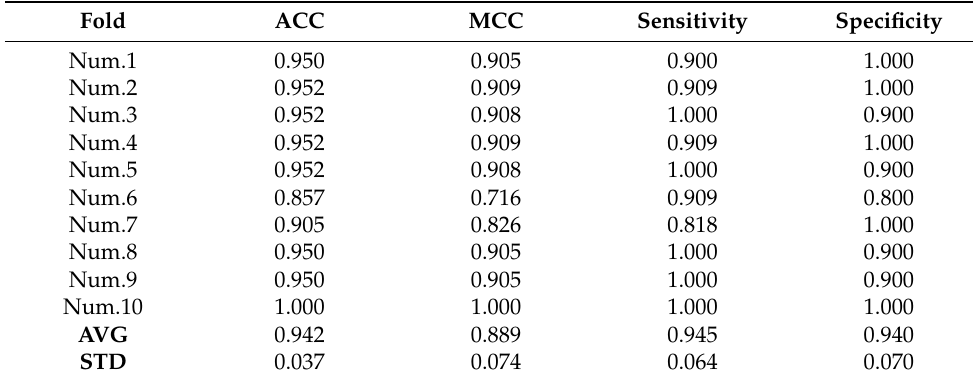
Table 2. Classification results of CBBOA-SVM-FS in the light of four metrics. Fold